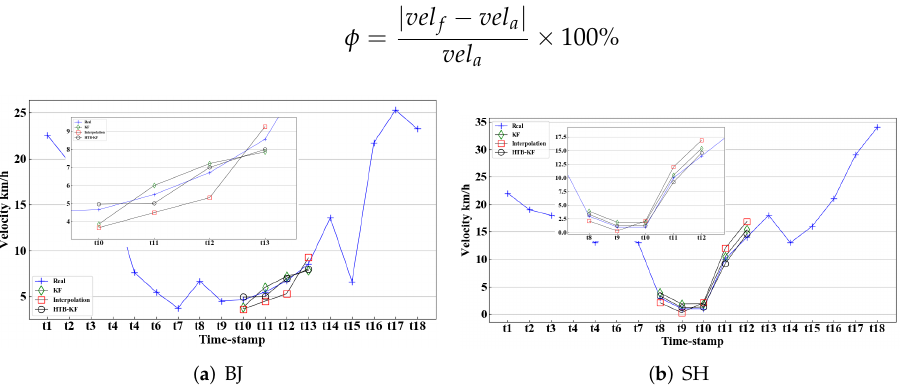
Figure 8. Comparison results of three trajectory restoration methods. ( a ) Comparison of taxi velocity information restoration in Beijing city. ( b ) Comparison of taxi velocity information restoration in Shanghai city.